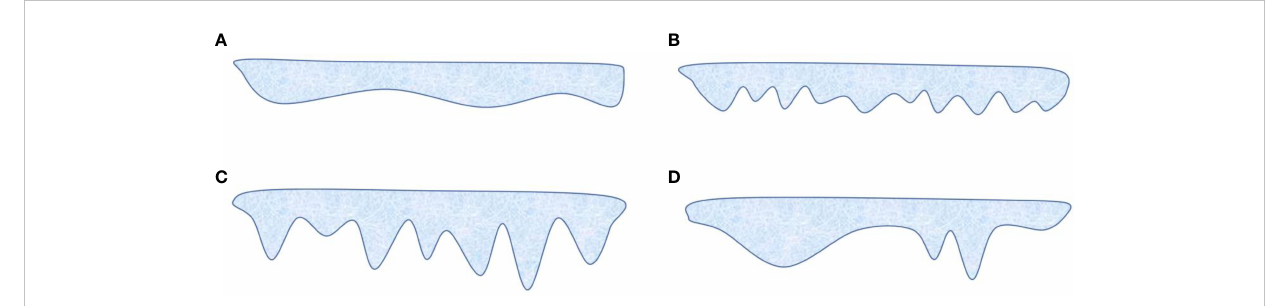
FIGURE 13 Underwater ice scenario comparisons (2D pro fi le of ice draft). (A) Flat or gradual feature. (B) Uniformly distributed coarse feature. (C) Uniformly distributed sharp feature. (D) Separated or clustered feature with different ice draft